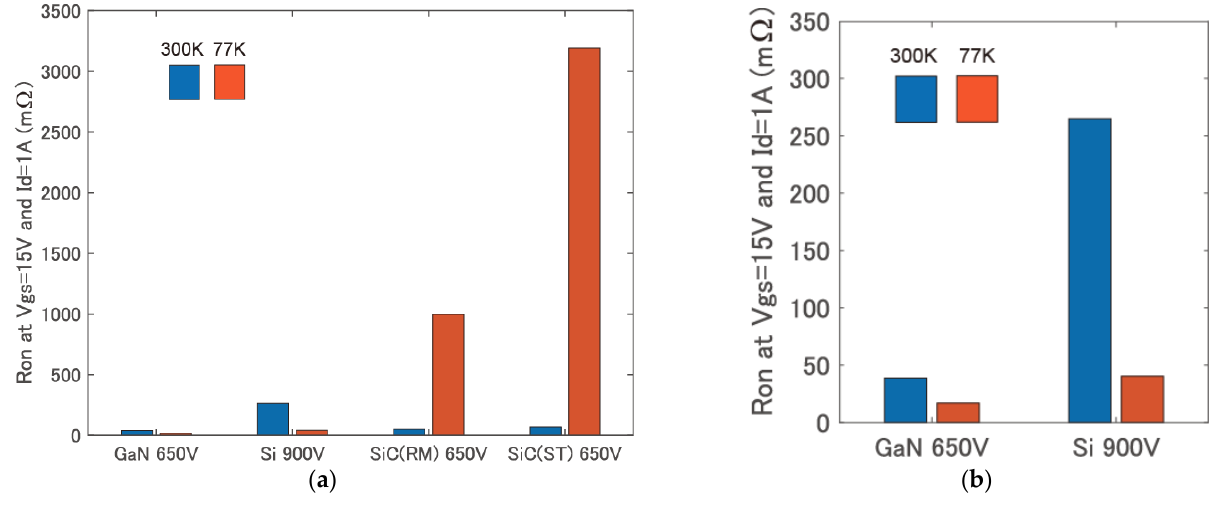
Figure 9. The experimentally measured ON resistance, R on , at 300 K and 77 K: ( a ) all the tested switches; ( b ) zoomed results for the Si SJ-MOS and GaN HEMT switches.